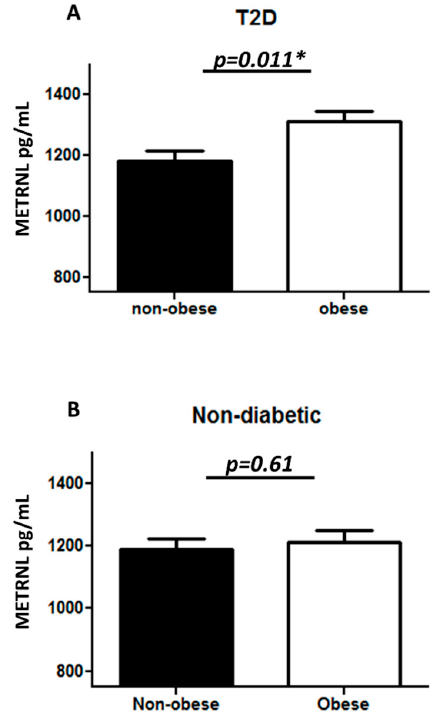
Figure 2. METRNL level in plasma following sub-classification into four groups: non-diabetic non-obese and obese (n = 124), and T2D non-obese and obese (n = 104). ( A ) Comparing non-diabetic non-obese to obese individuals; ( B ) plasma level of METRNL in T2D comparing non-obese to obese individuals. METRNL level in plasma was determined using enzyme linked immunosorbent assay. The population was classified on the basis of their diabetic status and further sub-classified on the basis of obesity. Diabetes was defined by fasting plasma glucose ≥ 126 mg / L (7 mmol / L). Obesity was defined based on BMI, where participants with BMI > 30 kg / m 2 were considered obese and those with BMI between 20 and 30 kg / m 2 were considered non-obese. Statistical assessment was 2-sided and considered statistically significant at * p < 0.05.